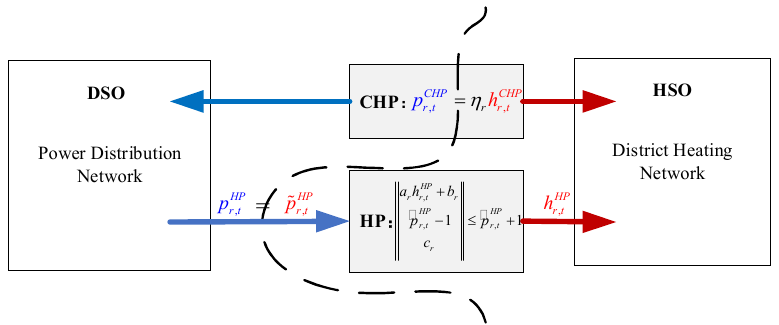
Figure 5. Illustrated example of how to apply the standard ADMM.